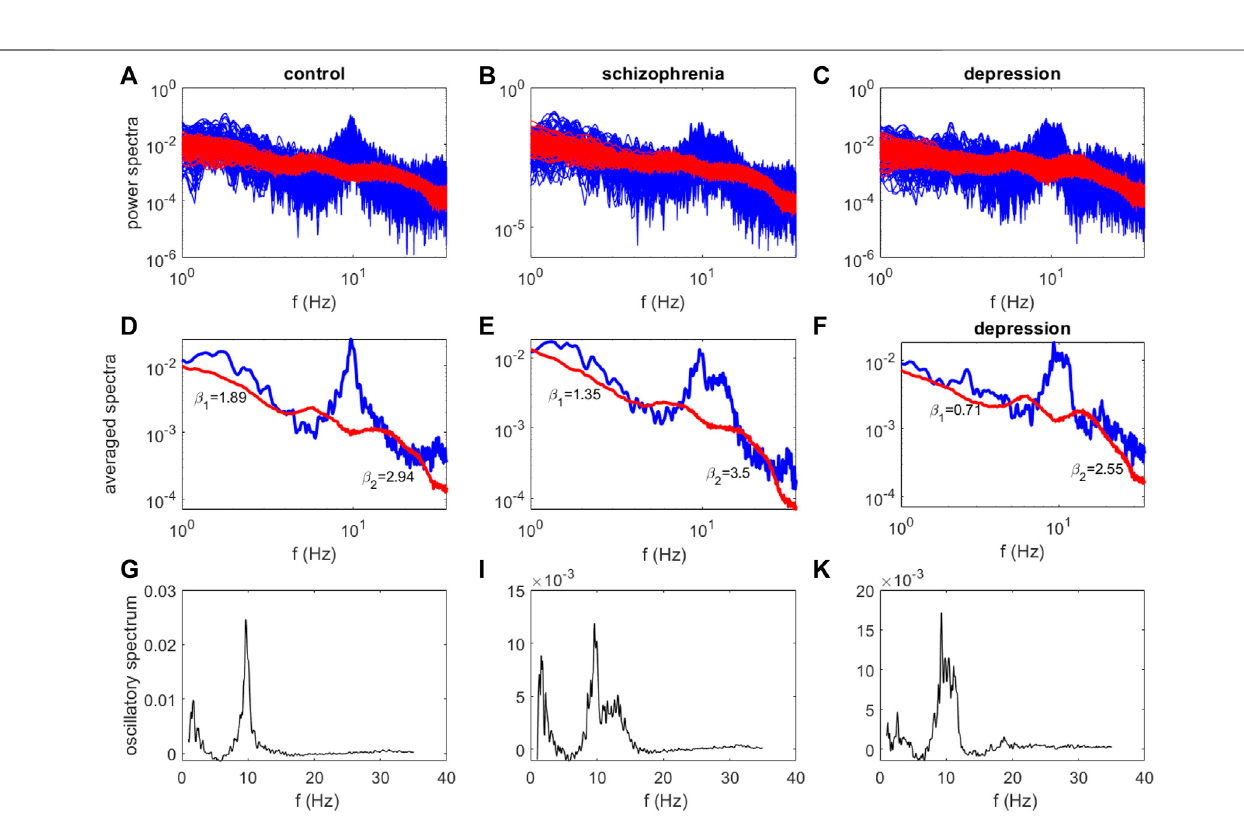
Frontiers in Physiology |